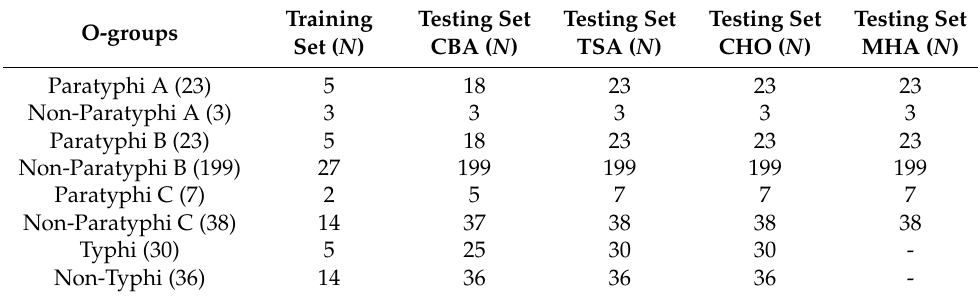
Table 2. Characterization of the training and the testing